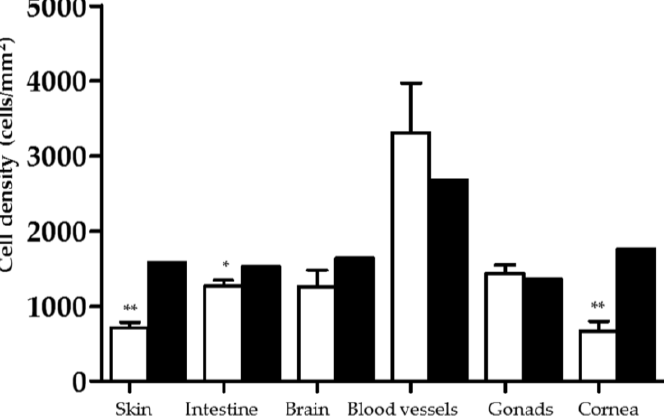
Figure 5. Cell density (cells/mm 2 ) on PEO(5%)coHSAm(5%)fb(0.5%) IPNs (white) and Thermanox ® (black) after a week of culture. This parameter was calculated after enzymatic dissociation using a trypsin-EDTA in Isoton II electrolyte solution at different time points (5, 10, 20, 30, 60 and 75 min) in physiological conditions (37 °C, 5% CO 2 , 90% humidity). * and ** indicate a significant difference ( p ≤ 0.05 and p ≤ 0.001, respectively) compared to the Thermanox ® control (Student’s t -test).